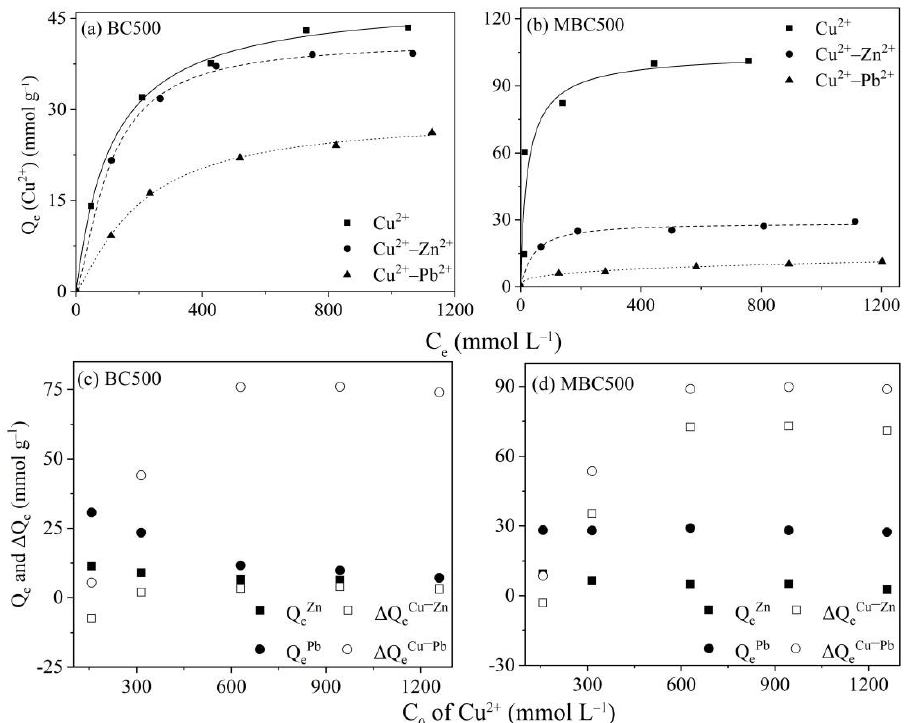
Figure 1. Effect of Zn 2+ /Pb 2+ on adsorption capacity of Cu 2+ on BC500 ( a , c ) and MBC500 ( b , d ) (Q eZn and Q ePb represent the adsorption capacities of Zn 2+ and Pb 2+ in the binary metal system; ∆ Q eCu − Zn and ∆ Q eCu − Pb represent the ∆ Q e of Cu 2+ in Cu 2+ –Zn 2+ and Cu 2+ –Pb 2+ competitive systems).